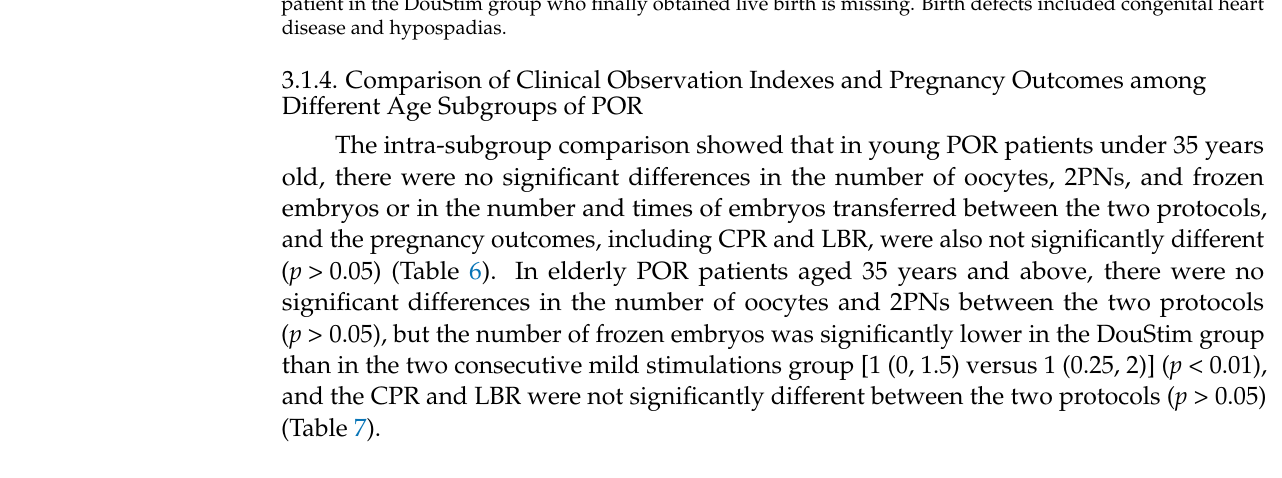
Table 4. Multivariate logistic regression analysis of clinical pregnancy rate.